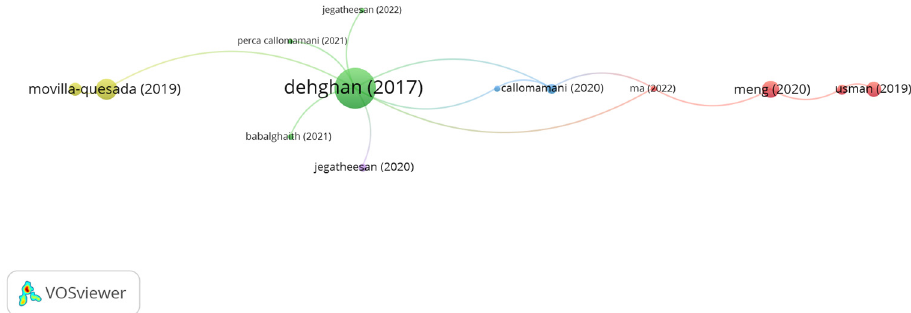
Figure 20. Network visualization of PET fibers.